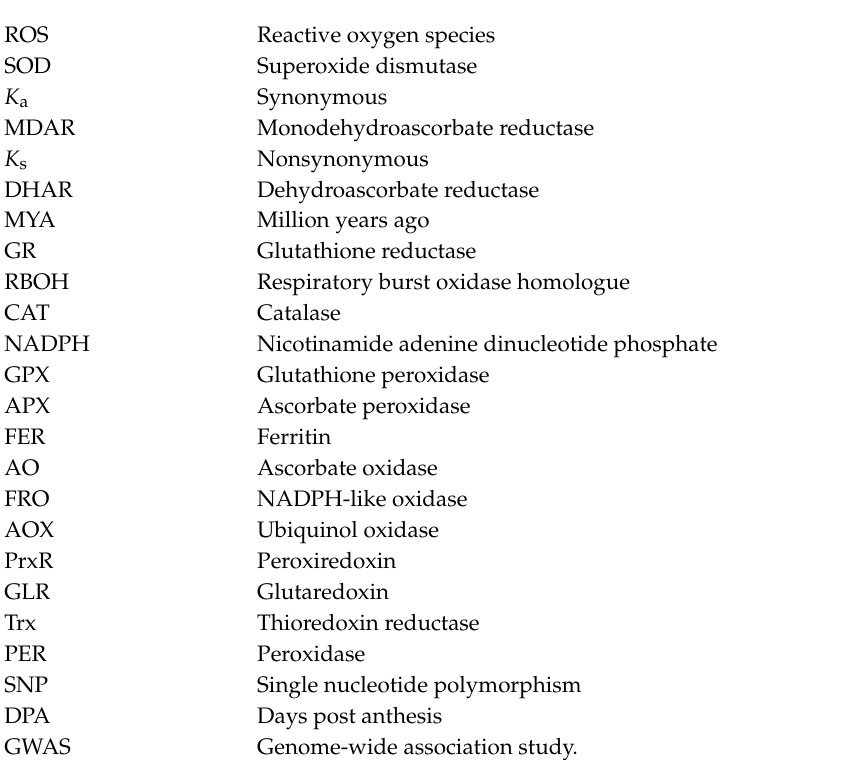
s1. Table S1. Characteristics of genes of ROS network in Gossypium hirsutum , G. arboreum, and G. raimondii ; Table S2. Synteny blocks of G.hirsutum and diploid cotton ( G. arboreum and G. raimondii ); Table S3. Orthologous gene pairs of G. hirsutum , G. arboreum , and G. raimondii ; Table S4. Expression levels of ROS network genes of G. hirsutum leaves under abiotic stress; Table S6. Summary of the results of RNA-seq and map to the G. hirsutum genome; Table S7. Gene accession number and samples information of transcriptome data used in our research; Table S8. Genes of ROS network within 2 Mb ( ± 1 Mb) of association signals; Figure S1. GO enrichment analysis of M85 and CRI12 under alkali-salt